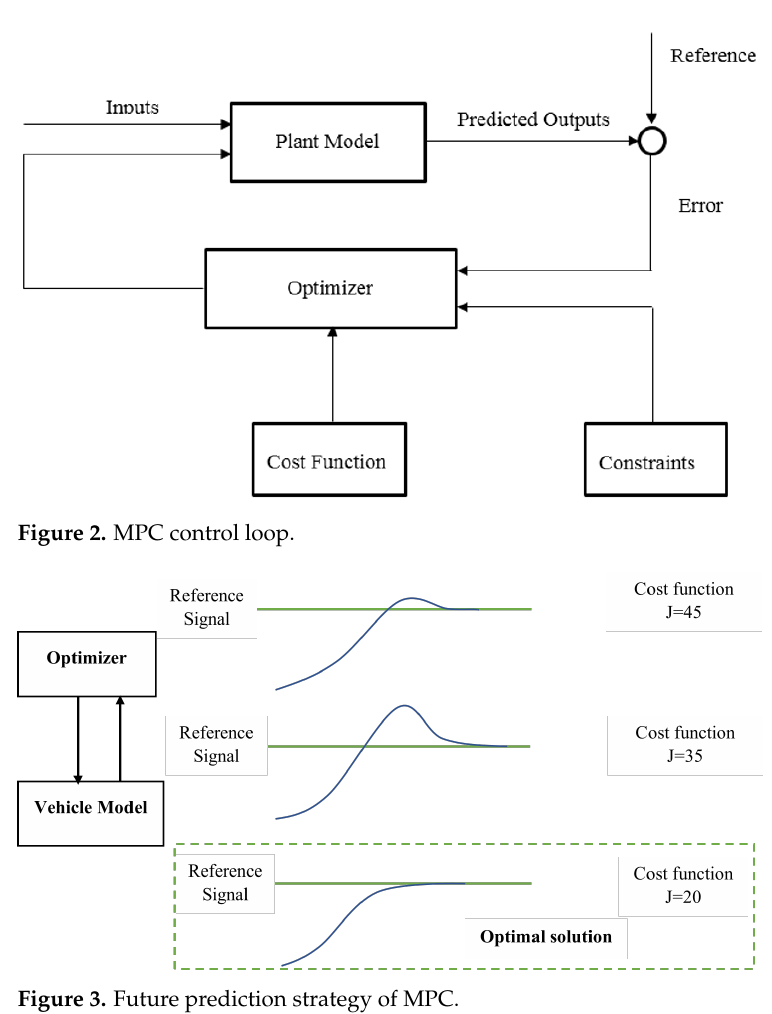
Figure 3. Future prediction strategy of MPC.